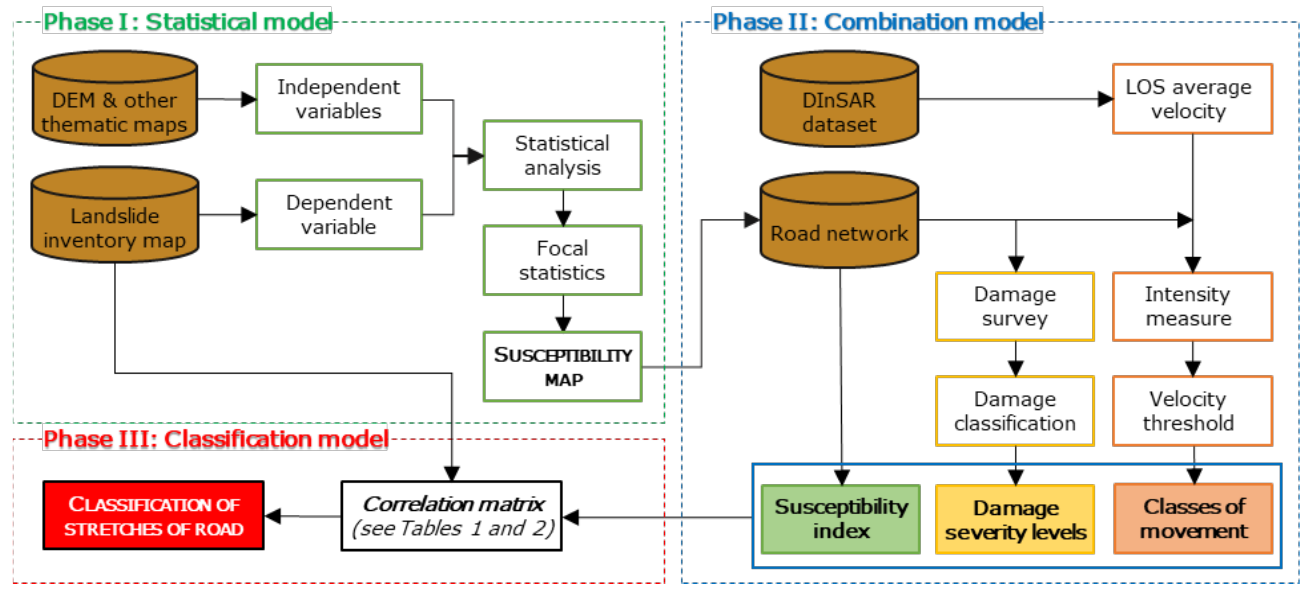
Figure 1. Procedure to study the interaction between slow-moving landslides and the road network at the municipal level by combining information from susceptibility maps, DInSAR data analyses and damage